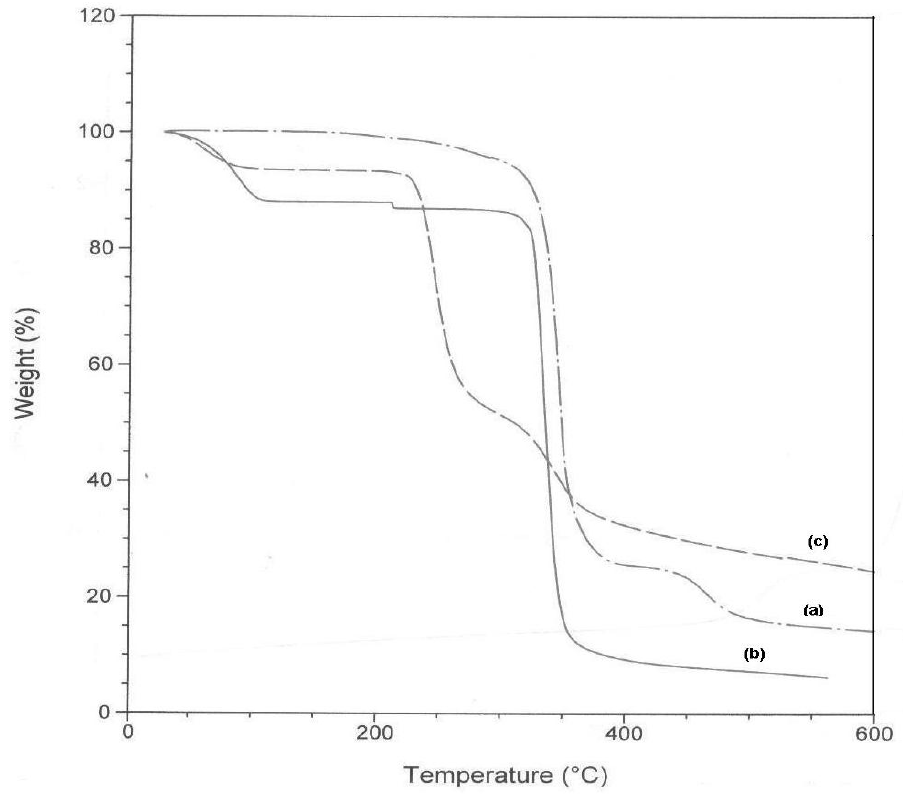
Figure 7. TGA curves of (a) TetraPhimBr, (b) β-CD and (c)